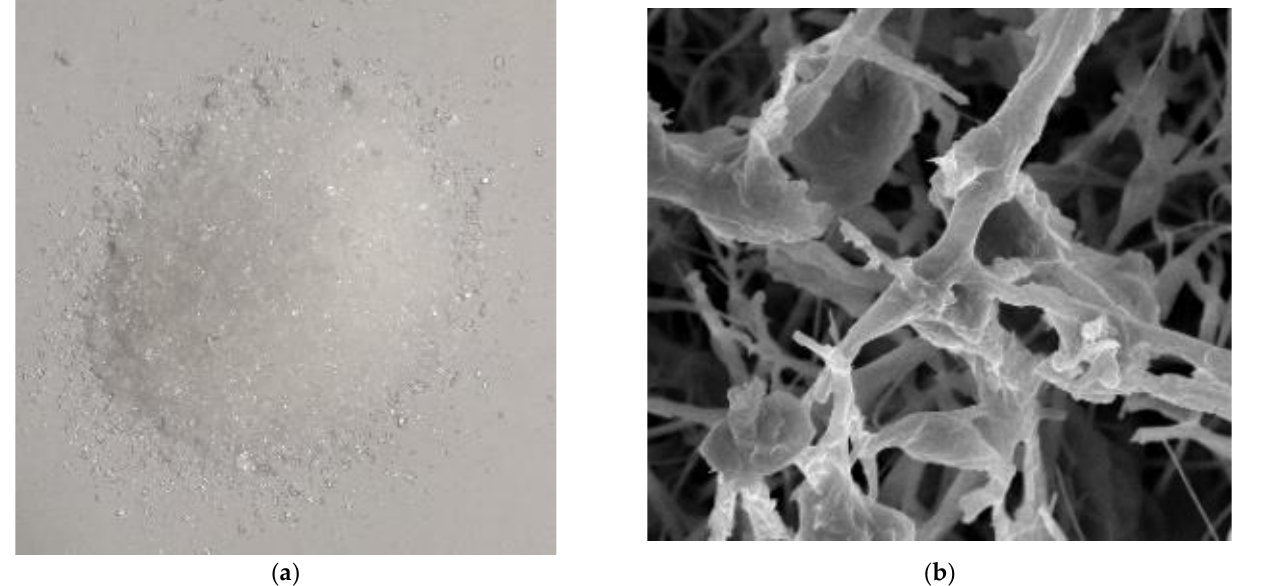
Figure 2. MgSO 4 and its SEM image: ( a ) MgSO 4 powder; ( b ) SEM microscopic image